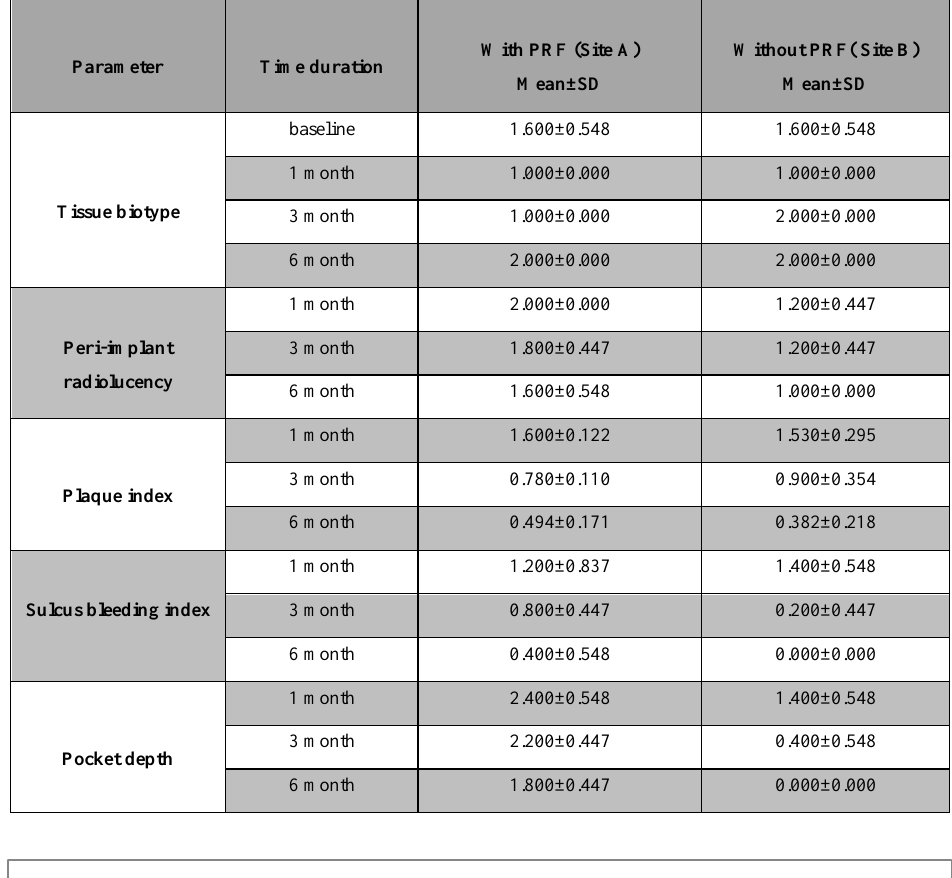
Table 2. Representing the descriptive analysis of site without L-PRF and with L-PRF.